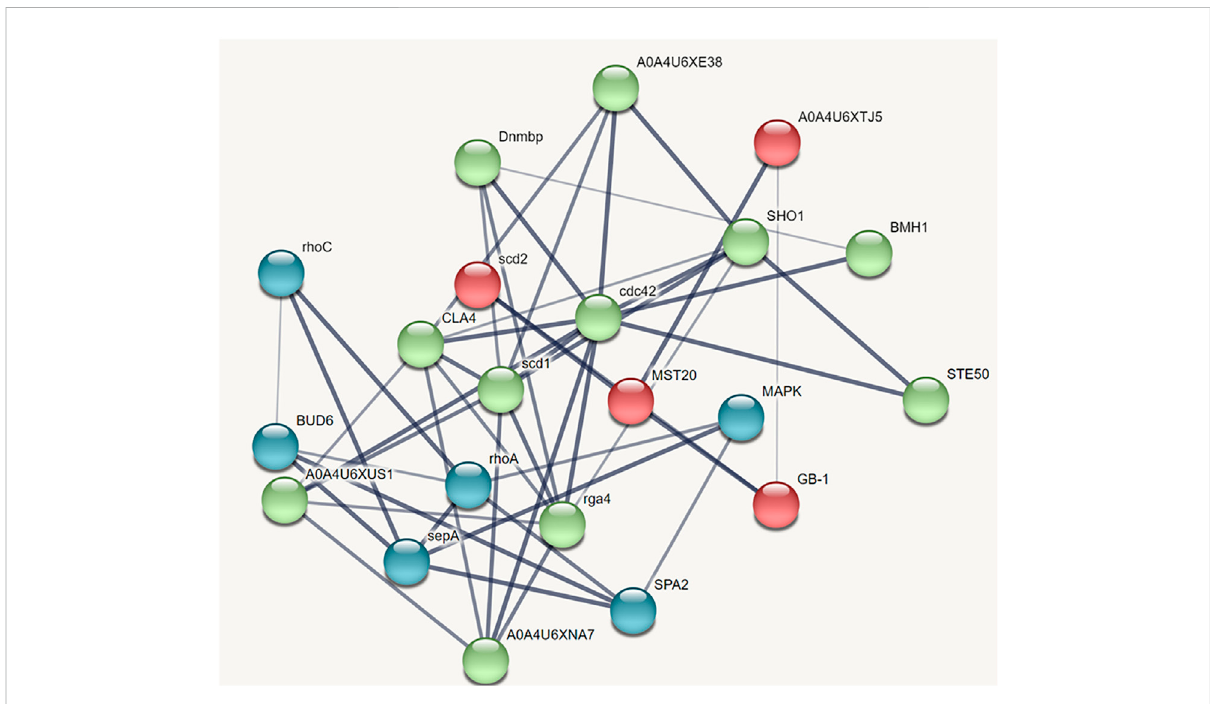
FIGURE 4 STRINGnetworkanalysisdisplayingprotein-proteininteractions.Colornodesrepresentsqueryproteinsand fi rstshellofinteractions.Redcolor node represents cluster 1, green color represents cluster 2 and blue color represents cluster